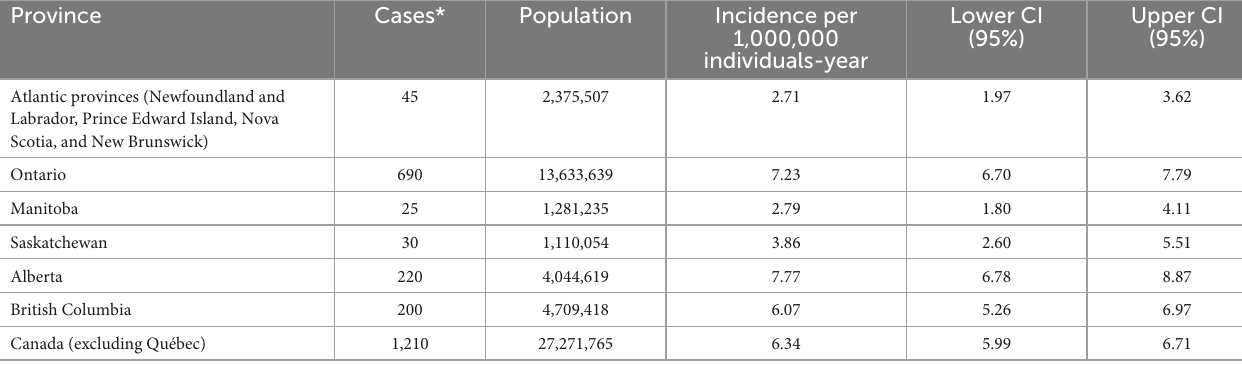
TABLE 2 Comparison of uveal melanoma incidence rates across Canadian provinces. Province